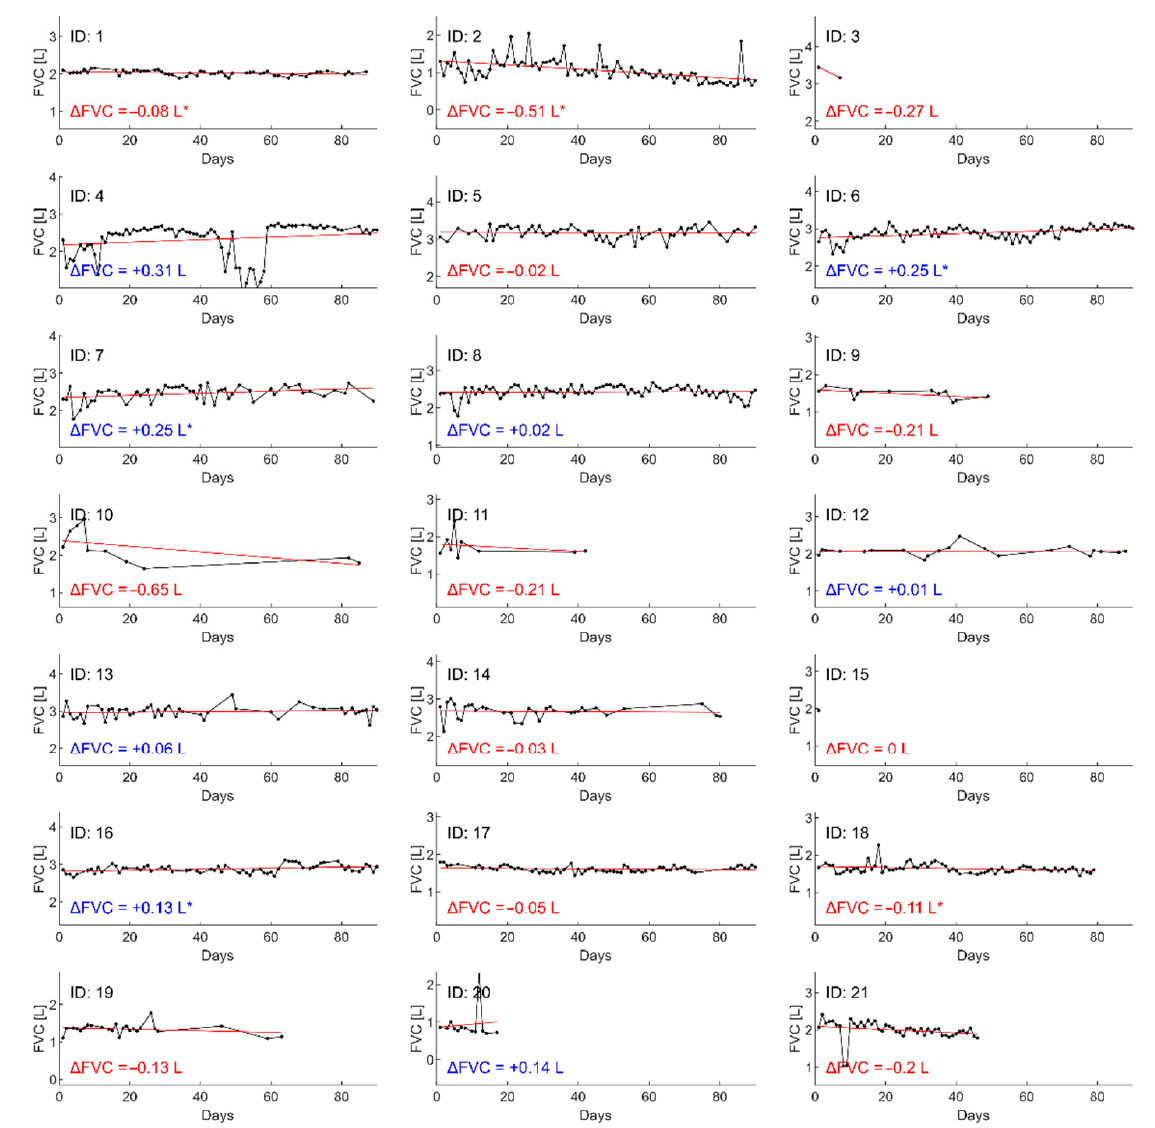
Figure 2. Daily forced vital capacity (FVC (L) charts with a matched straight line for individual participants. Change in spirometry parameter values ( ∆ FVC) over 90 days was calculated using linear regression for each parameter. After fitting a straight line, the difference at d = 90 days (or last day of monitoring) and day = 0 was calculated. Symbol * means that the slope coefficient of the fitted lines is significantly different from zero ( p -value < 0.05).